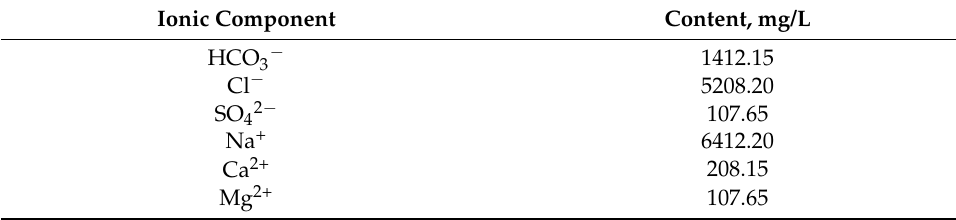
Figure 1. Differential scanning calorimetry (DSC) curve of the HPAM. Table 1. The ionic component content of the simulated formation water.